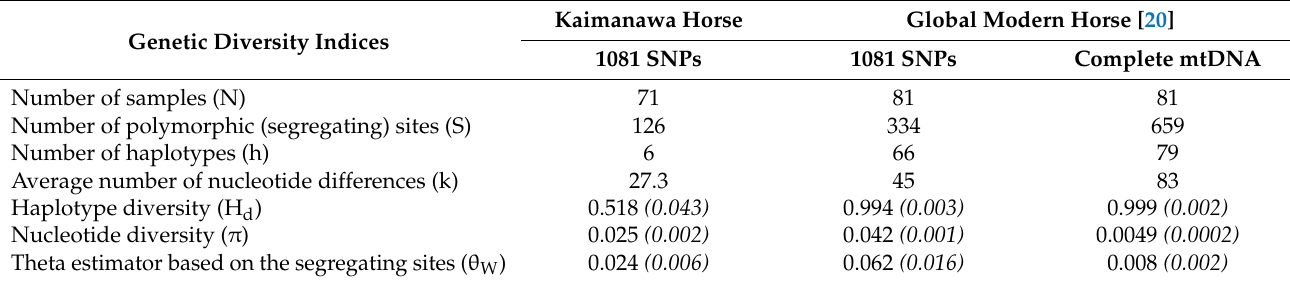
Table 1. Mitochondrial DNA (mtDNA) genetic diversity indices calculated for the KHs and the global modern horse dataset [20] based on the 1081 SNPs and complete mtDNA sequences (16,600 bp). The standard deviation values are shown in